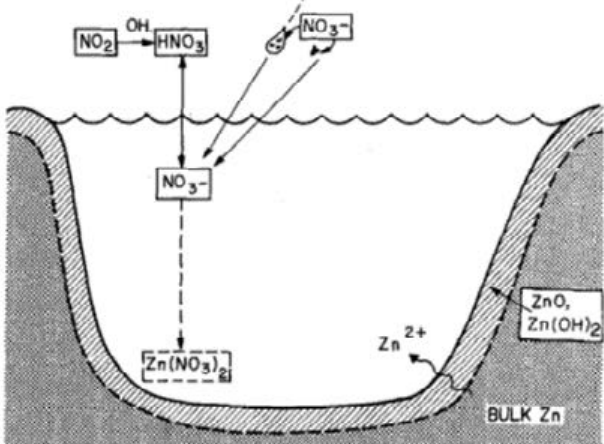
Fig. 1: A schematic representation of the processes involved in the formation of components containing nitrogen during the atmospheric zinc corrosion (Graedel, 1989)